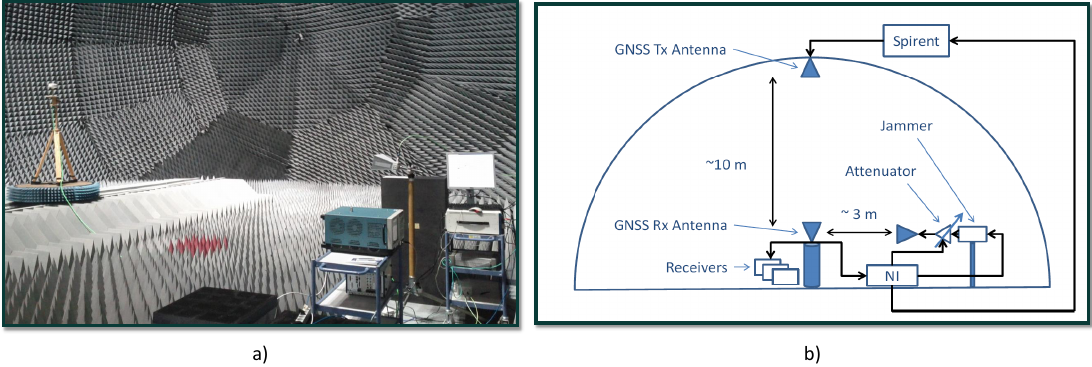
Figure 6. Anechoic chamber experiment involving hardware-simulated GPS and Galileo signals. ( a ) View of the anechoic chamber. ( b ) Schematic representation of the experimental setup.